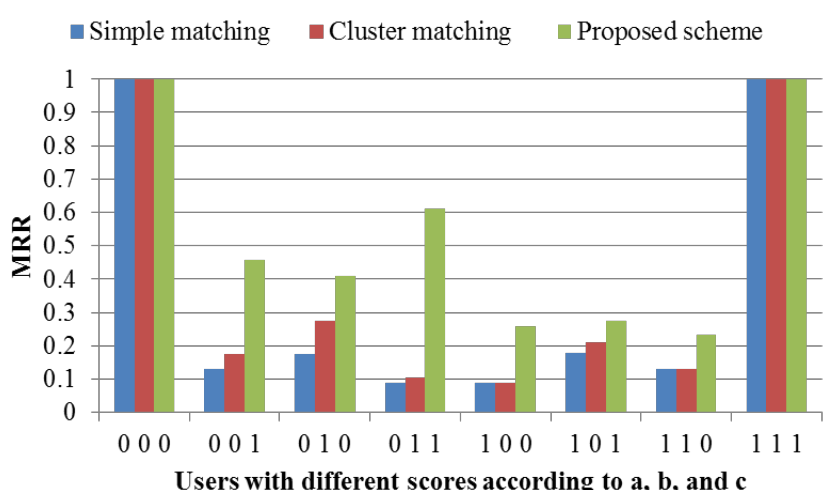
Figure 9. Mean Reciprocal Rank (MRR) evaluation results.